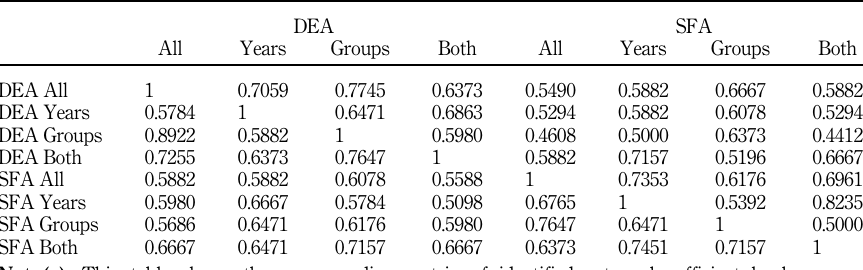
Table 6. Consistency of